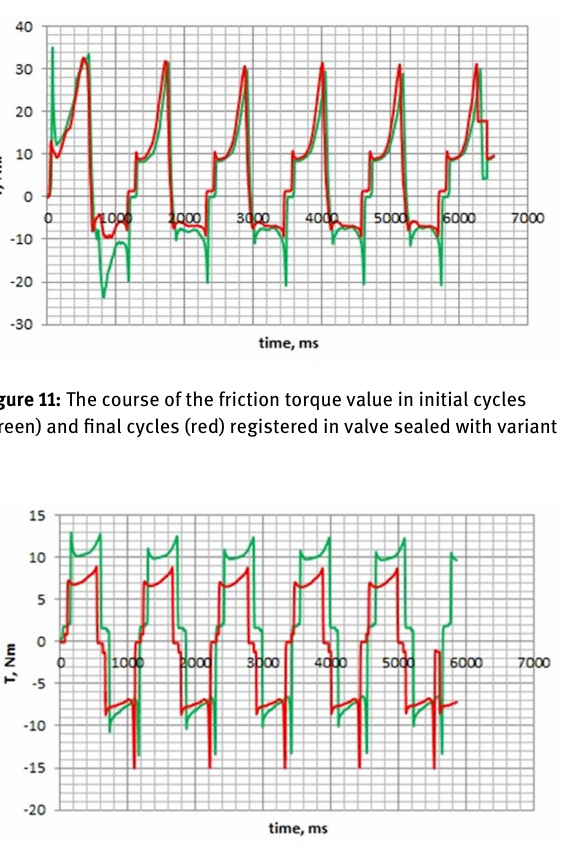
Figure 12: The course of the friction torque value in initial cycles (green) and final cycles (red) registered in valve sealed with variant